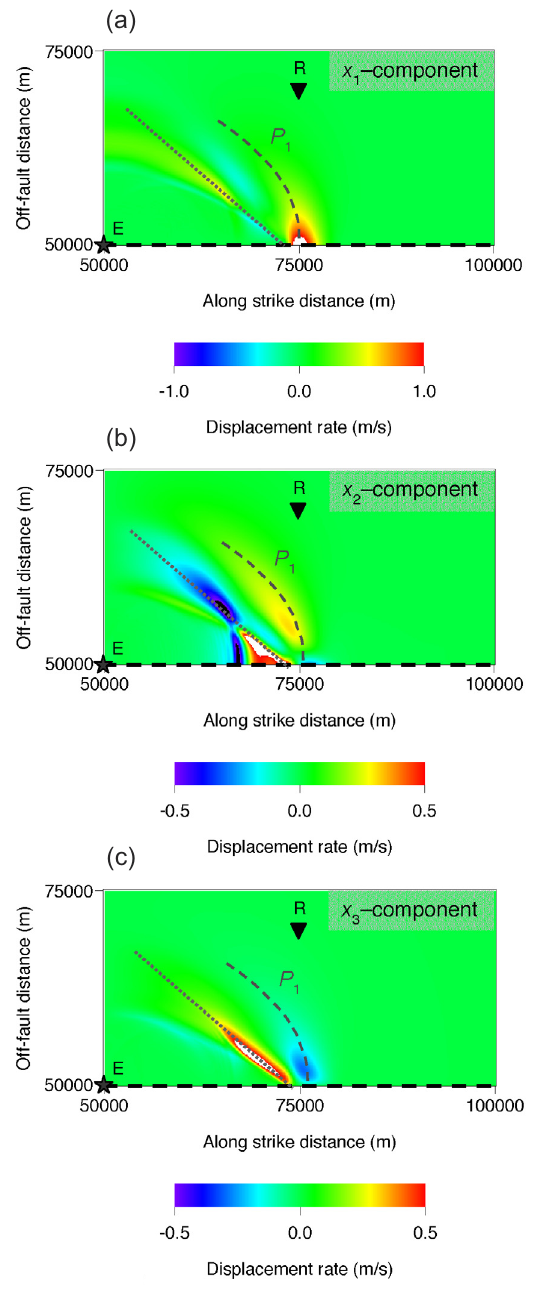
Figure 14. The same as in Figure 11, but now in the case of multi- ple point-sources (see Section 5 for